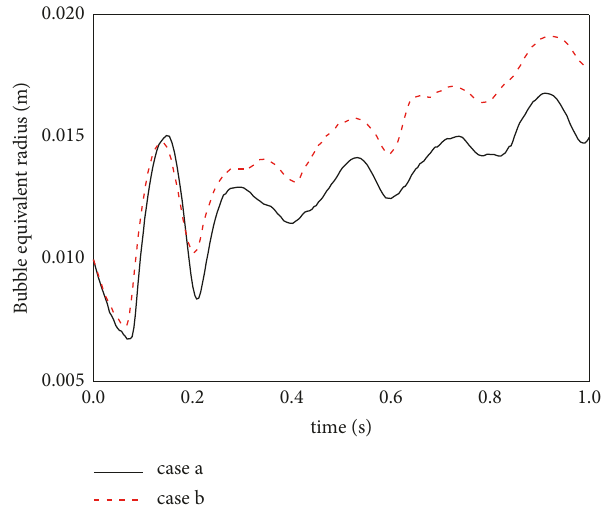
Figure 8: Equivalent radius of bubble under flow pulsation condi- tion.